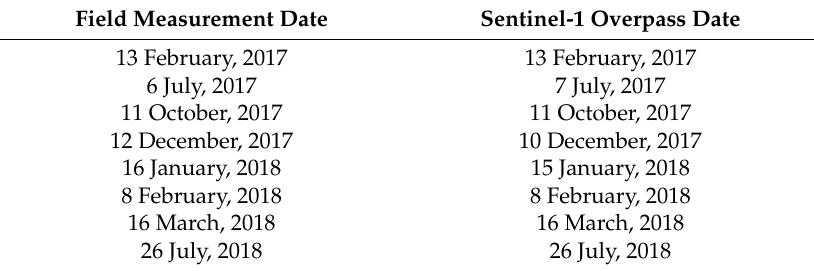
Table 1. Field sampling and corresponding Sentinel-1A image acquisition dates.